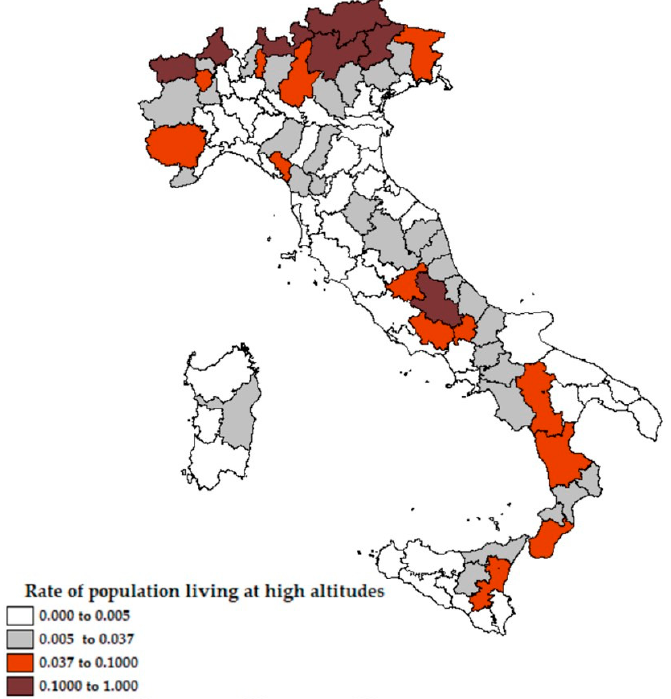
Figure 4. Rate of population living at high altitudes (1200 m above sea level) for each Italian prov- ince.